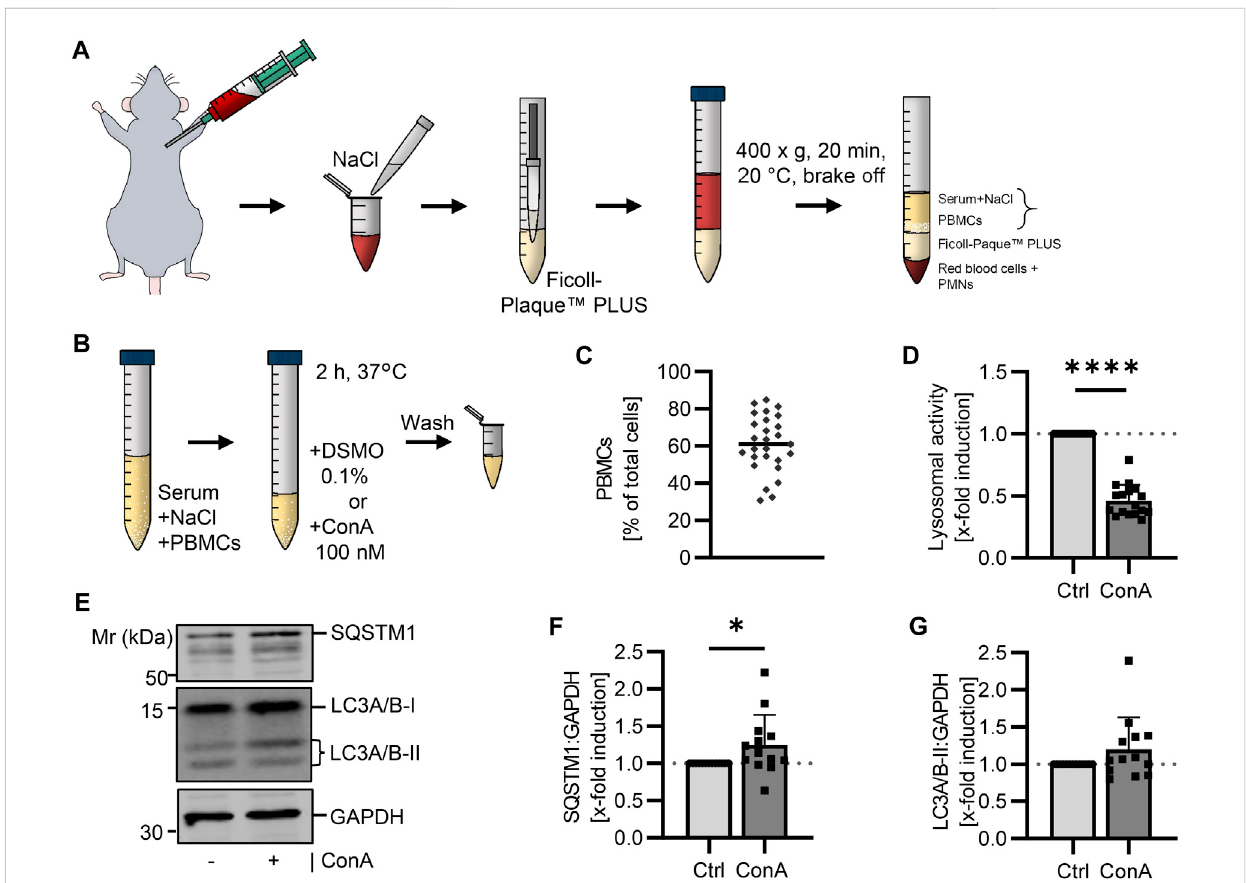
FIGURE 1 Determination of the autophagic fl ux in isolated murine PBMCs using a lysosomal inhibitor. (A) Blood was collected from young (21-22 w) B6 mice. ThewholebloodwasdilutedwithNaClandlayeredaboveFicoll-Paque ™ PLUS.Aftercentrifugation,serum(dilutedwithNaCl)andPBMCswerecarefully collected. (B) Murine PBMCs were treated in serum-NaCl solution with 100 nM ConA for 2 h at 37 ° C. (C) Percentage of PBMCs on total isolated cells was counted after May Grunwald-Giemsa stain ( n = 27). (D) Lysosomal activity was decreased in ConA treated PBMCs. Activity was measured by CathepsinBandLmediatedreleaseofAMCafter75 min( n =16). (E) RepresentativewesternblotforSQSTM1,LC3A/B-I,LC3A/B-II andGAPDHincontrol andConAtreatedPBMCs. (F) SQSTM1normalizedtoGAPDHwasenhancedinConAtreatedPBMCs( n =13). (G) LC3A/B-IInormalizedtoGAPDHwasnot affectedby ConA treatment.Data represent mean ±SD. Statistical signi fi cance was tested withone sample Wilcoxon testand givenas follows:* p ≤ 0.05, ** p ≤ 0.01, **** p ≤ 0.0001. Mr, molecular weight